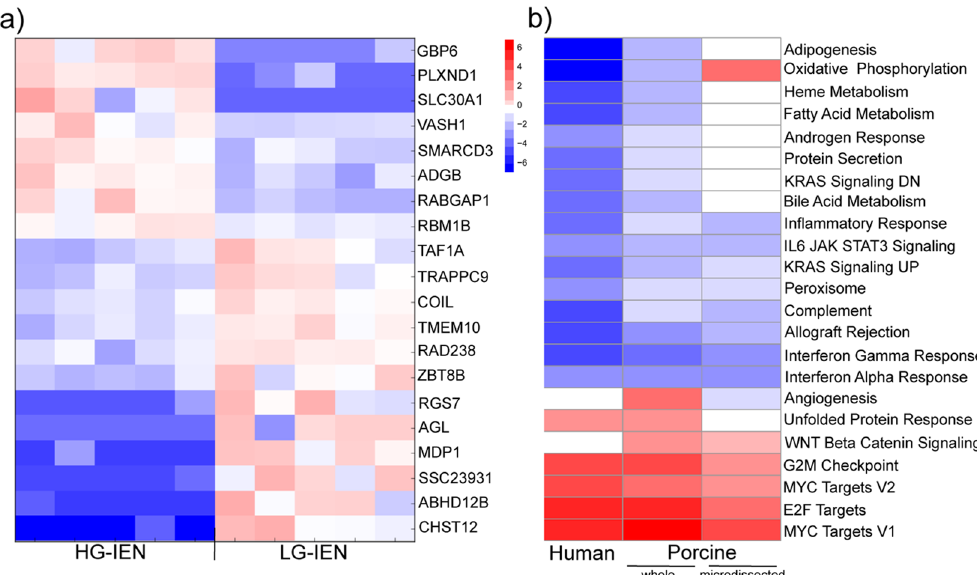
Figure 2. Transcriptome pattern specific for microdissected low- (LG-IEN) and high-grade intraepithelial (HG-IEN) adenomas in polyps of APC 1311/ + pigs. ( a ) Heatmap of top 20 genes showing transcriptome pattern specific for microdissected LG-IEN and HG-IEN. ( b ) Comparison of gene set enrichment analysis for human T1 stage polyps versus normal colonic mucosa; porcine LG-IEN versus HG-IEN polyp whole samples; and microdissected porcine LG-IEN and